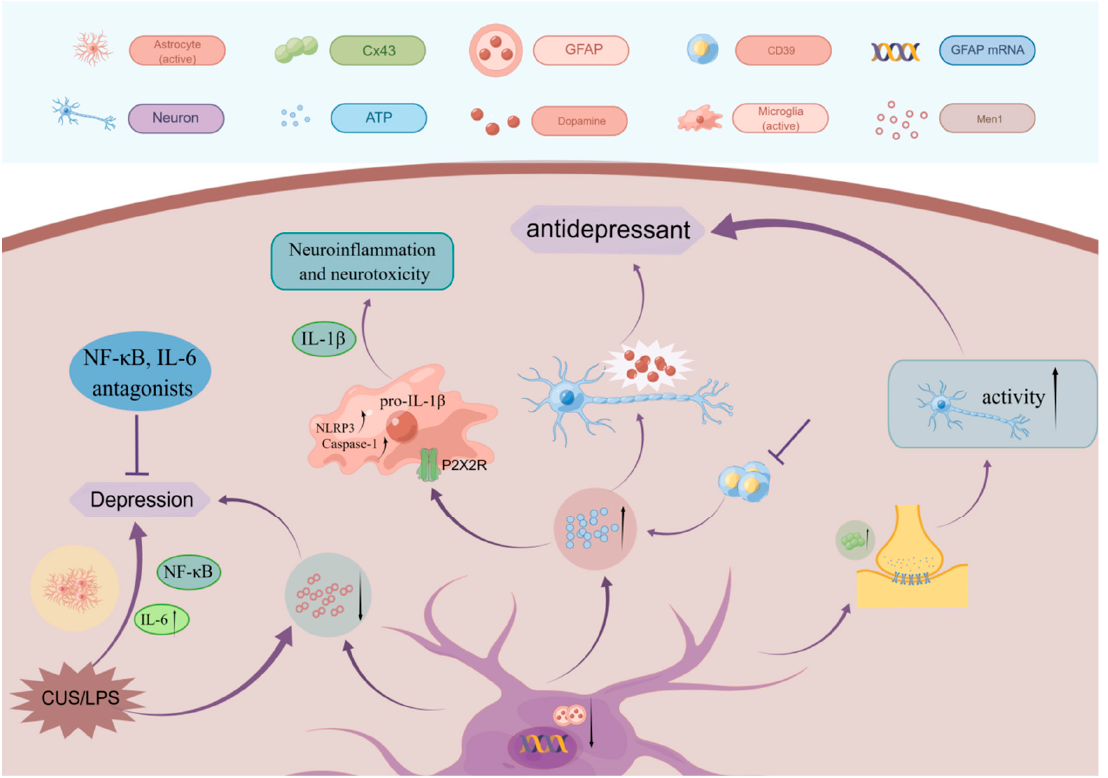
Figure 2. Association of astrocytes with depression. Reducing astrocyte-specific Men1 and lps-induced astrocyte activation both cause depression-like behavior, which can be ameliorated by inhibiting astrocyte activation. Additionally, GFAP, ATP, and connexin alterations were discovered with the onset and treatment of depression.